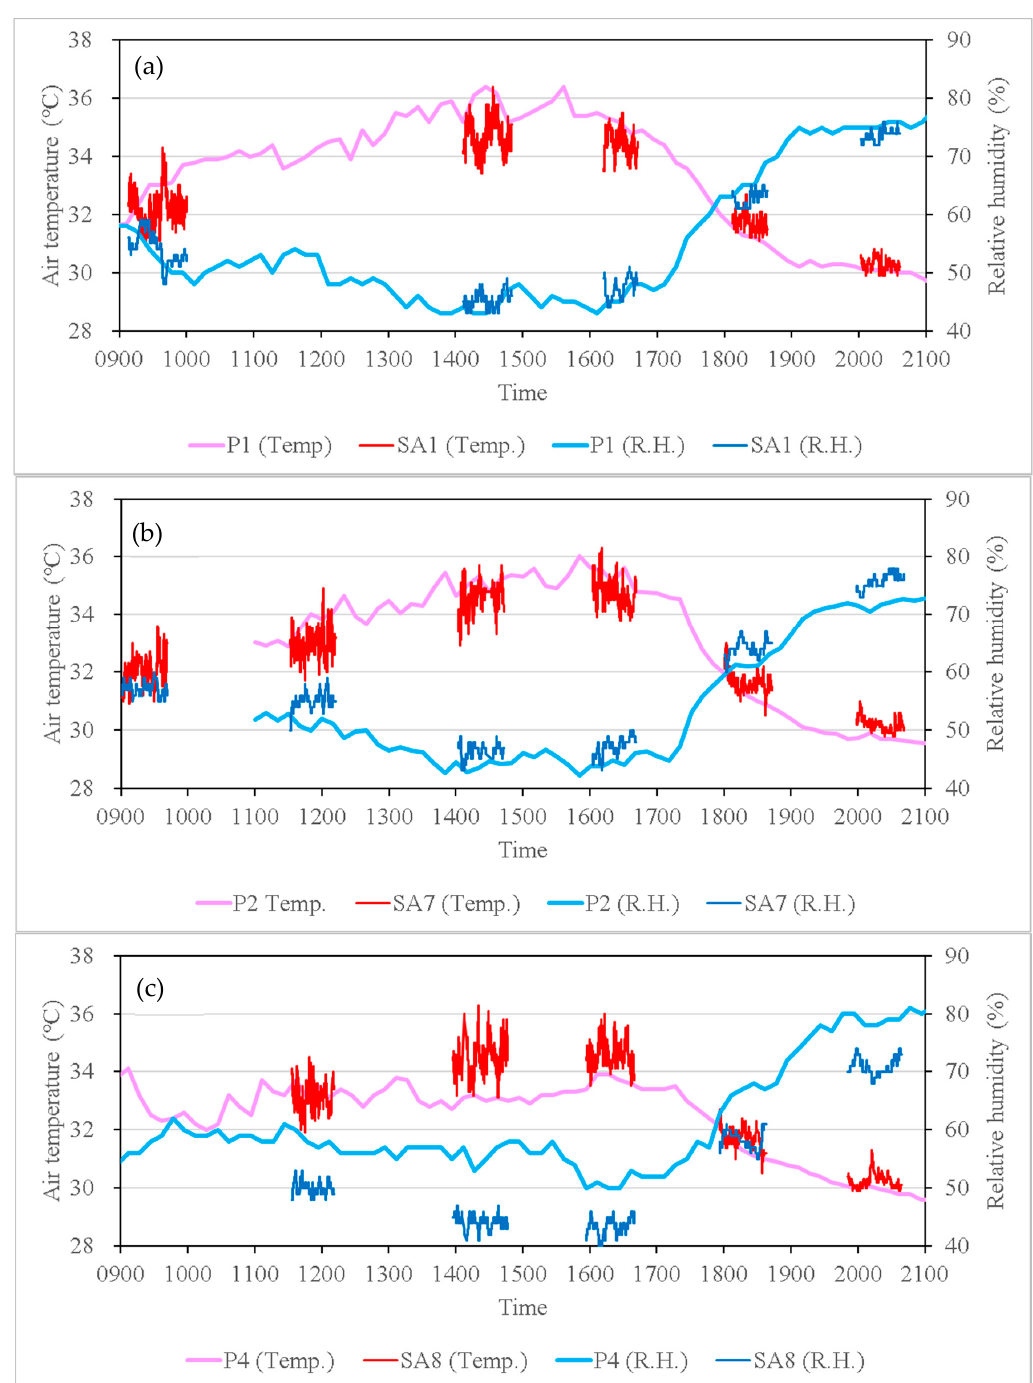
Figure 5. Time series variations of the air temperature and the relative humidity obtained at a stationary point and mobile observations in the subarea on 31 August. ( a ) P1 and Subarea-1, ( b ) P2 and Subarea-7, ( c ) P4 and Subarea-8.